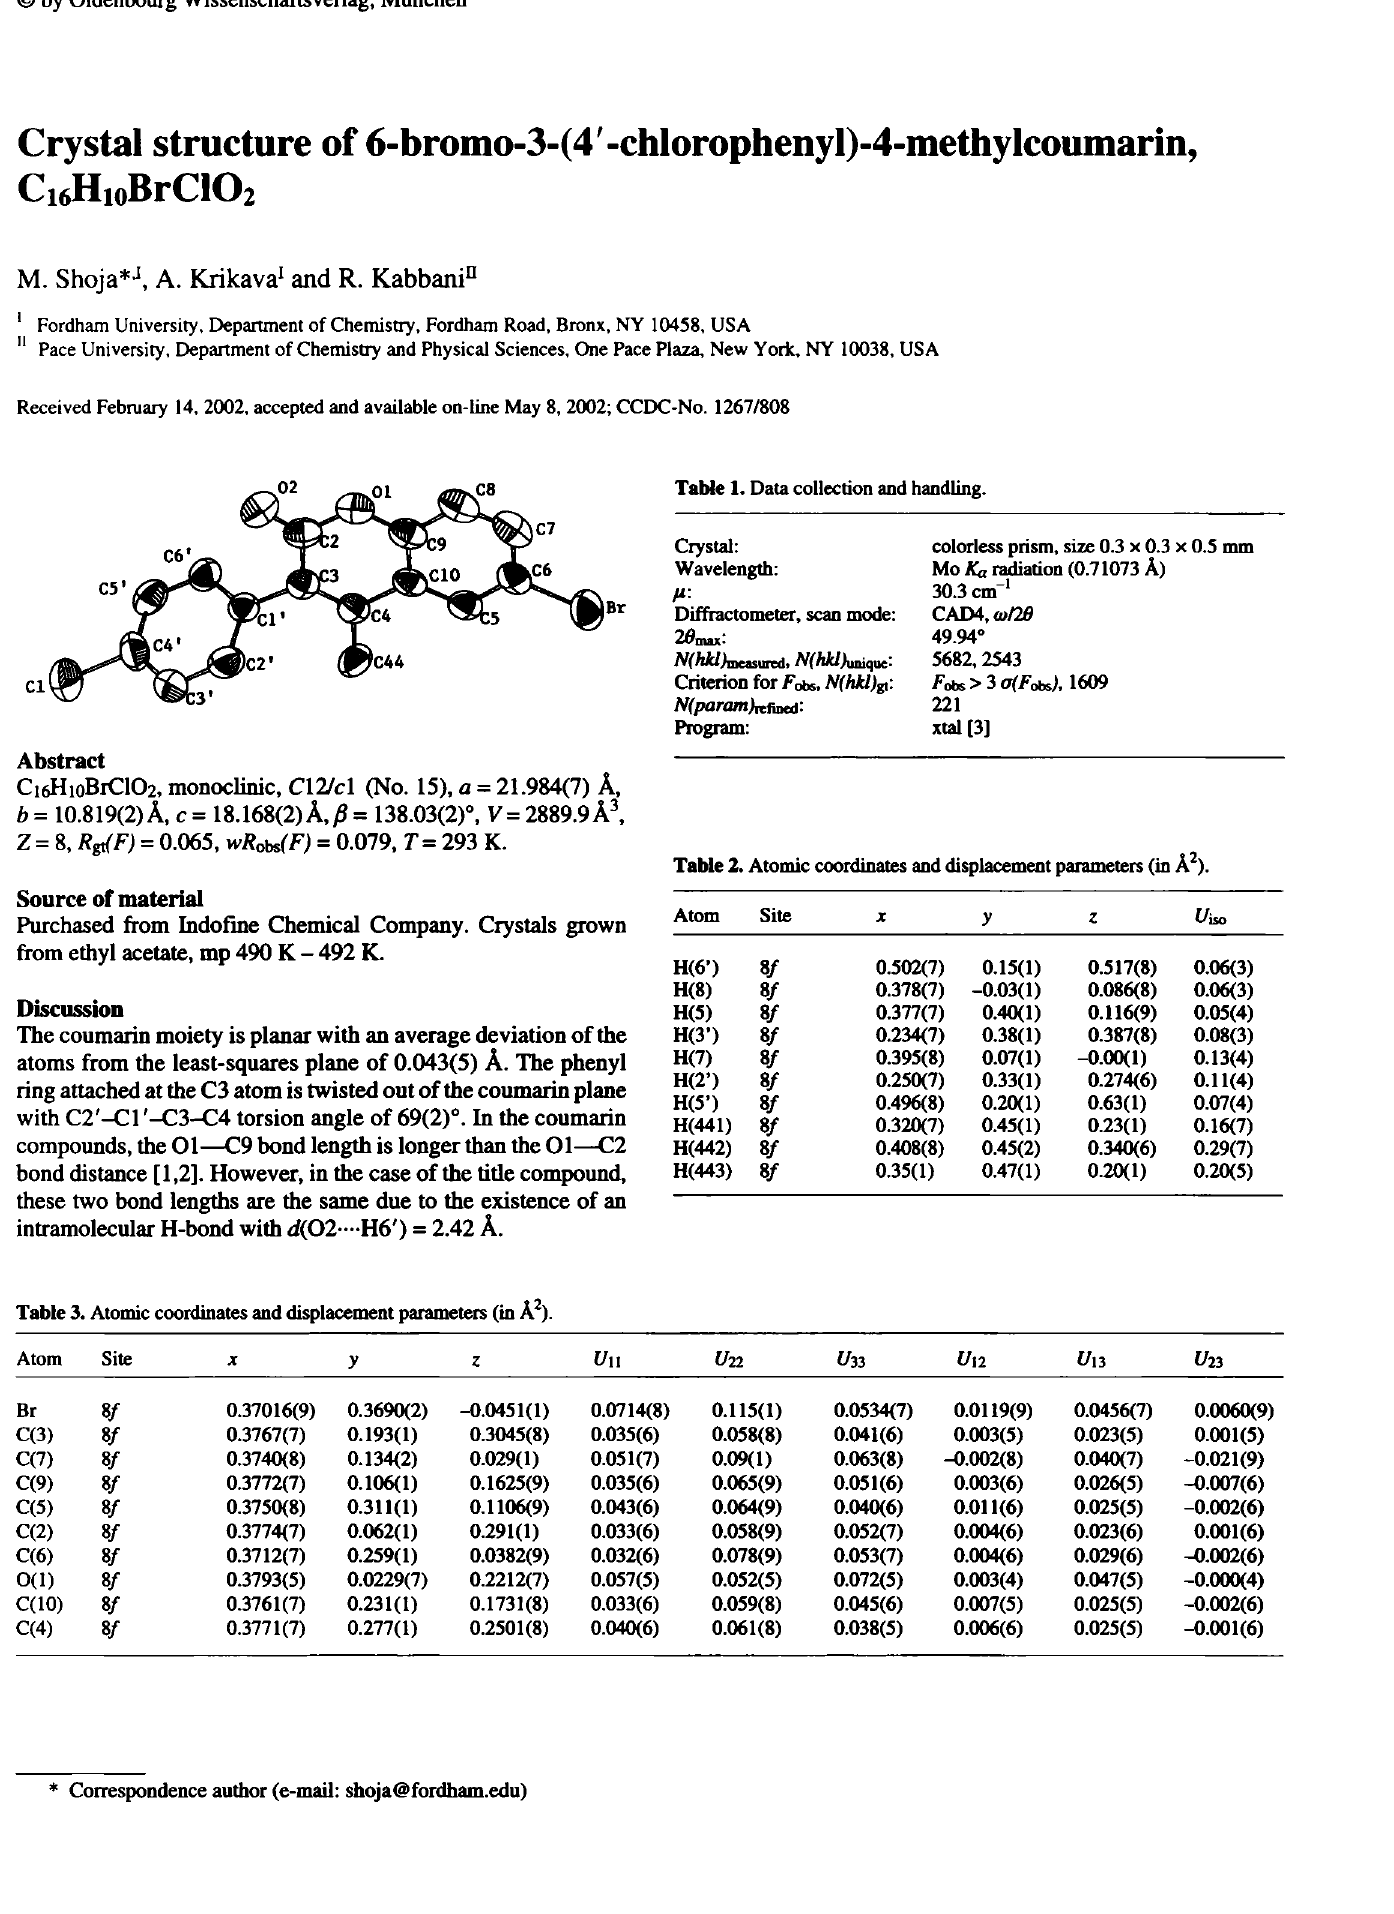
Table 3. Atomic coordinates and displacement parameters (in Â 2